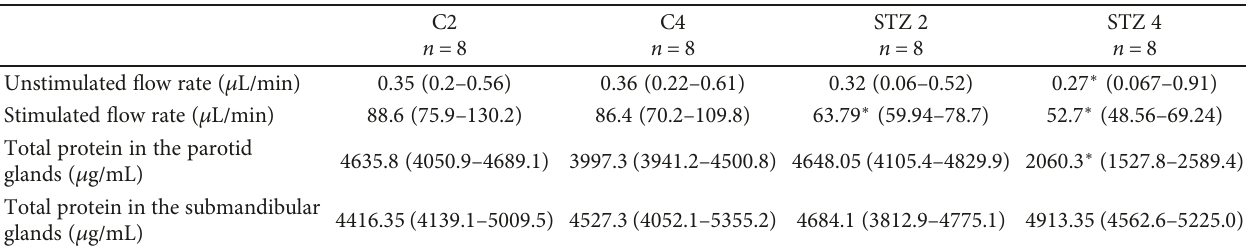
Table 2: The e ff ect of STZ-induced diabetes on salivary fl ow and total protein concentration [M (min – max)].